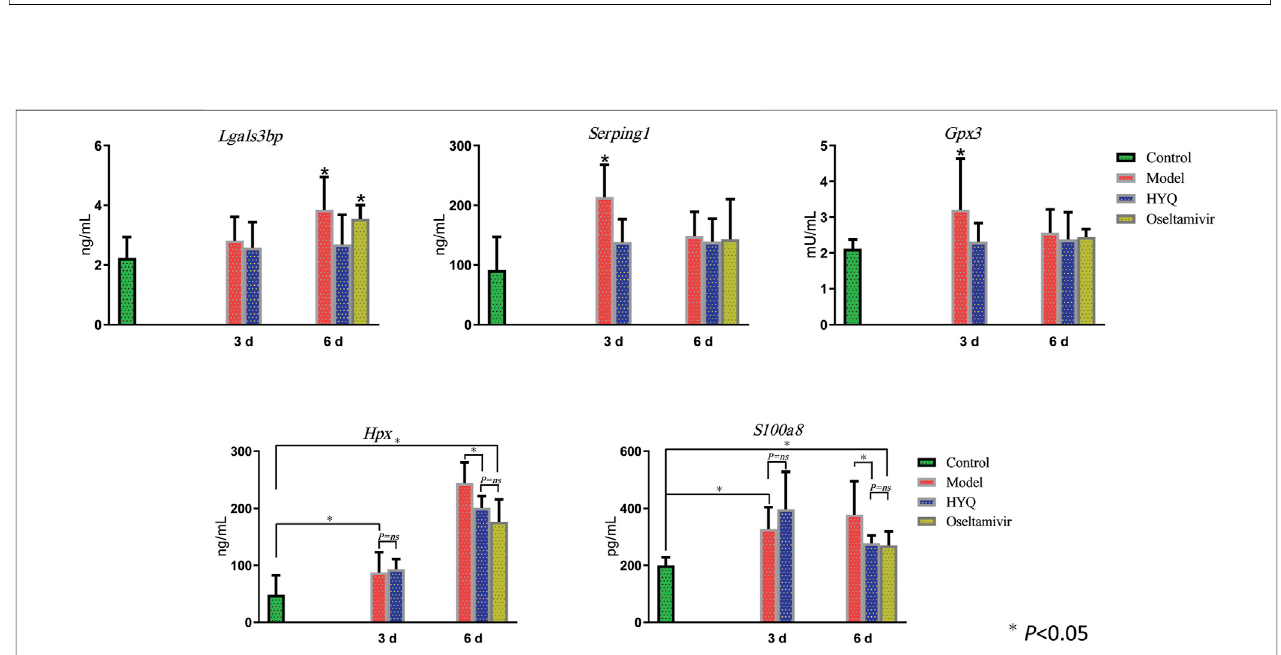
FIGURE6| ELISA-basedveri fi cationofthecandidatesignaturesregulatedbyHYQagainstviralpneumoniainmouseblood.Eachgroupcontained6mice,andthe results from each mouse were analyzed by one-way analysis of variance; 3 and 6 days: virus infection time. ns: no signi fi cance. Lgals3bp , galectin-3-binding protein; Serping1 , plasma protease C1 inhibitor; Gpx3 , glutathione peroxidase 3; Hpx , hemopexin; S100a8 , protein S100-A8.